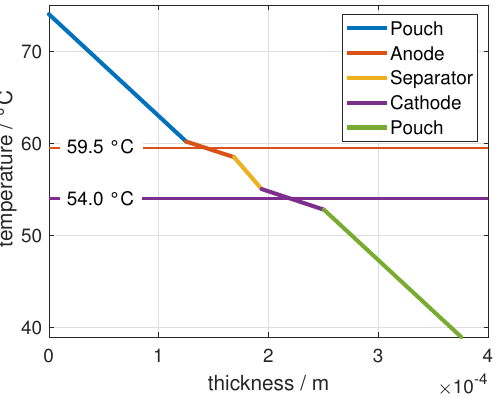
Figure 3. Estimated steady state temperature profile across the width of a single-layered Li-ion cell assuming a warm side of 74 ◦ C and a cold side of 39 ◦